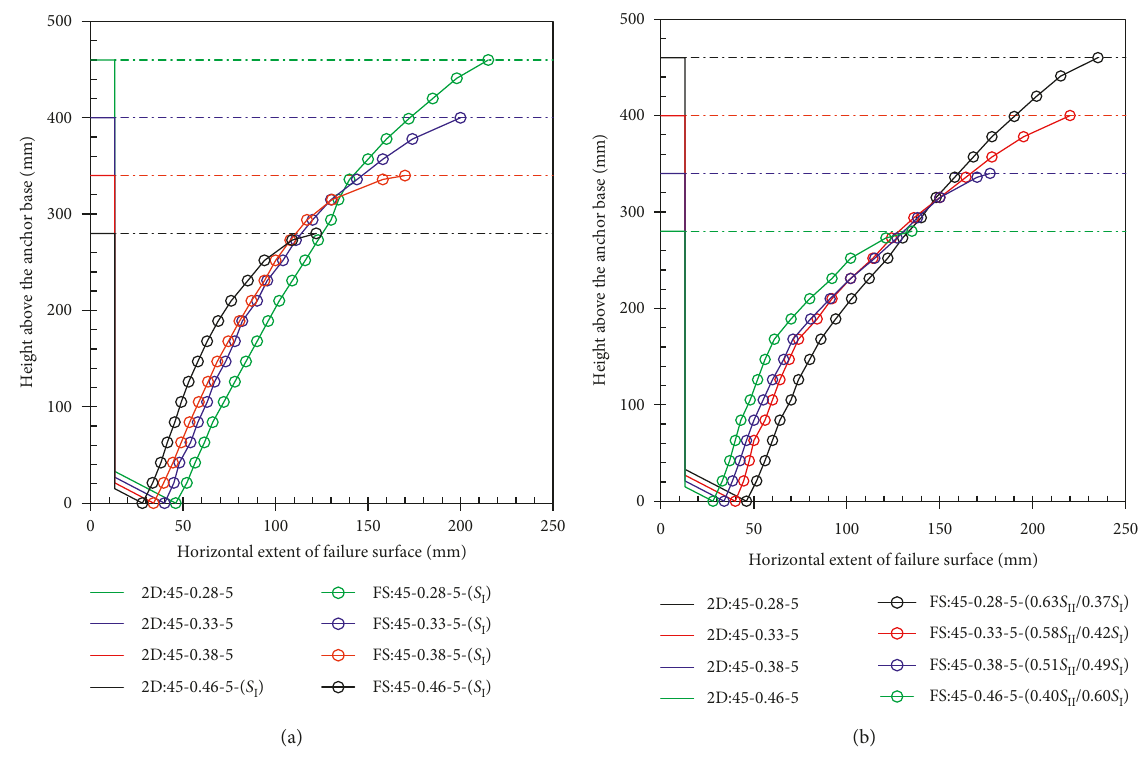
Figure 10: Height above the anchor base vs. horizontal extent of failure surface besides (a) panels having a 0.33, 0.38, and 0.46 in homogeneous sand deposit ( S I ) and (b) panels having a deposit ( S II / S I